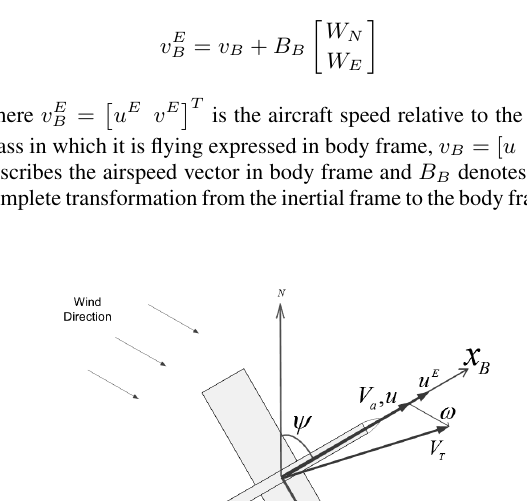
Figure 1: Forces and moments acting on the airplane